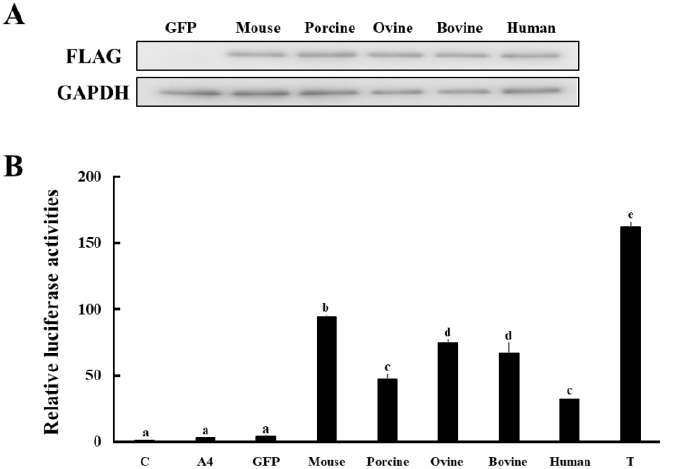
Figure 4. Comparison of enzymatic activities of HSD17B1/Hsd17b1 in various species. ( A ) Western blot analyses were performed with the antibodies against FLAG-tag and GAPDH using lysates of GFP- and FLAG-tagged HSD17B1/Hsd17b1 (mouse, porcine, ovine, bovine, and human)-introduced HEK293 cells. ( B ) Activation of AR-mediated transcription by culture media from GFP or each HSD17B1/Hsd17b1-introduced HEK293 cells collected at 2 h after A4 addition. CV-1 cells were transfected with ARE-Luc and AR expression vectors. At 24 h post-transfection, cells were incubated with vehicle (lane C), A4 (1 nM), T (1 nM), or culture medium from GFP- and each species HSD17B1/Hsd17b1-expressing HEK293 cells for 24 h. Values of the vehicle were defined as 1. Data represent the mean ± SEM of four independent experiments. Values marked by the different letters are significantly different from each other ( p < 0.05).